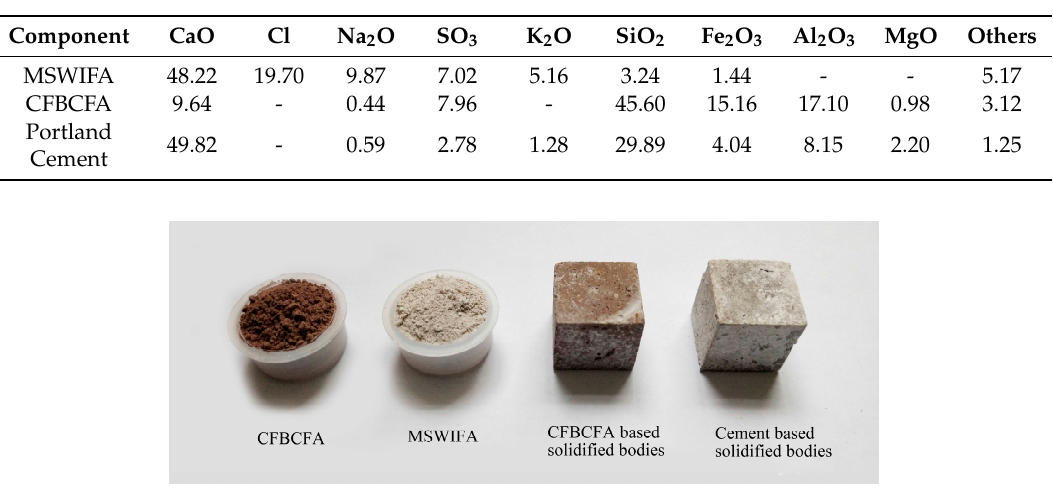
Figure 1. The appearance of MSWIFA, CFBCFA, CFBCFA and cement based solidified bodies.